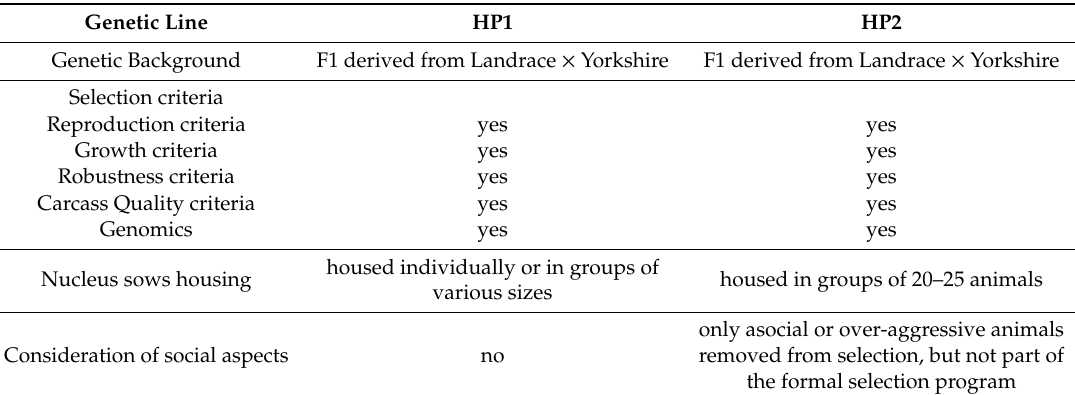
Table 1. Summary of the selection program and housing conditions of nucleus sows in the two independent Canadian